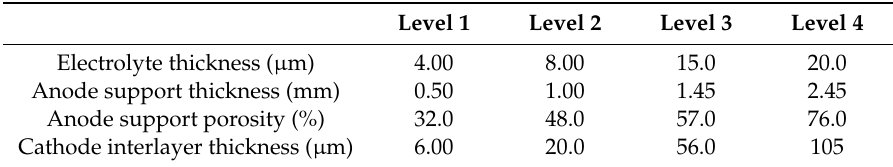
Table 1. The levels of the design parameters.